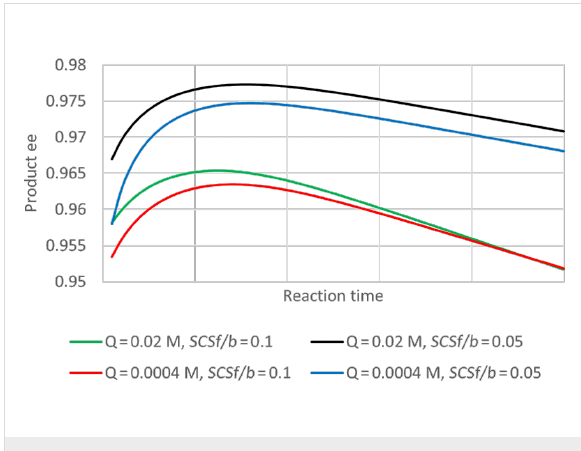
Figure 10: Increase in the product ee as the reaction proceeds for “ping-pong, both” kinetics, diacid esterification. There is no point for exactly zero time, because no product has been formed. Other param- eters were: S 0 = 0.2 M, B 0 = 0.5 M, K eq = 10, E = 39, K S = 0.1 M, k 2R = 1000 s − 1 , SCRf / b = 0.5, E2 / E = 0.5, SCR2f / SCRf = 1, k 4R / k 2R = k about 0.92, very close to the equilibrium